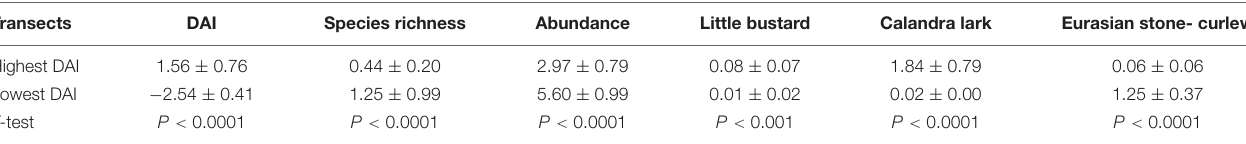
TABLE 2 | Mean and standard deviation (SD) of dryland affinity index (DAI), species richness (species/ha) and total and specific species abundance (birds/ha) of the 10 transects with highest and lowest DAI values.